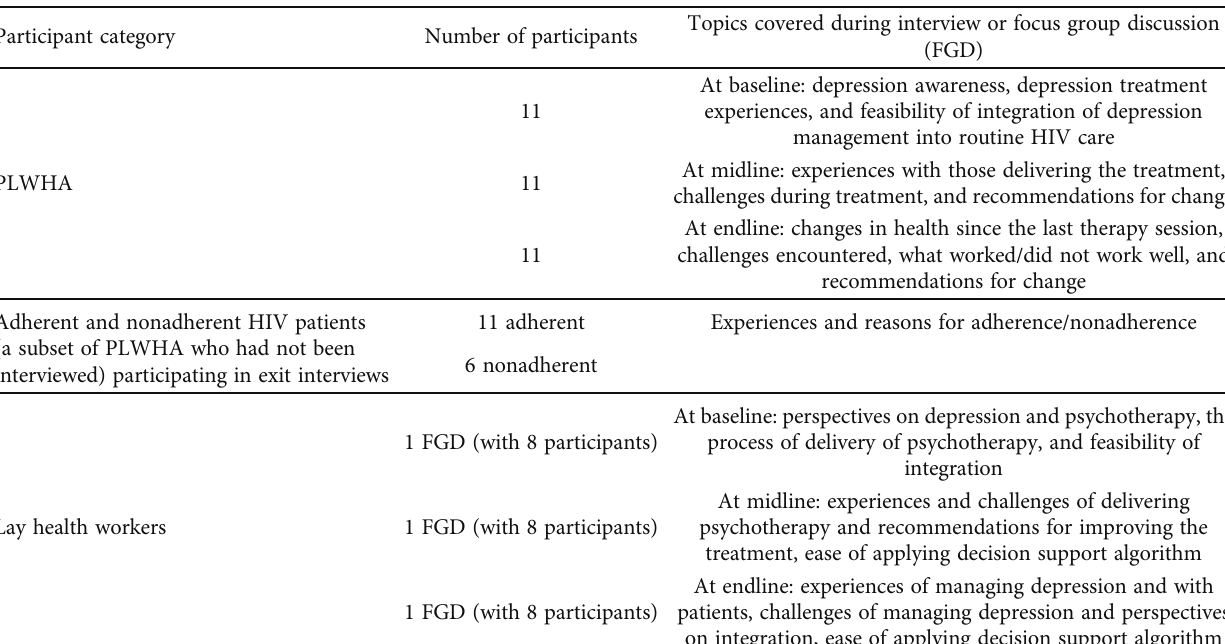
Table 1: Main topics covered and number of participants involved in the interviews with the di ff erent categories of participants at di ff erent time